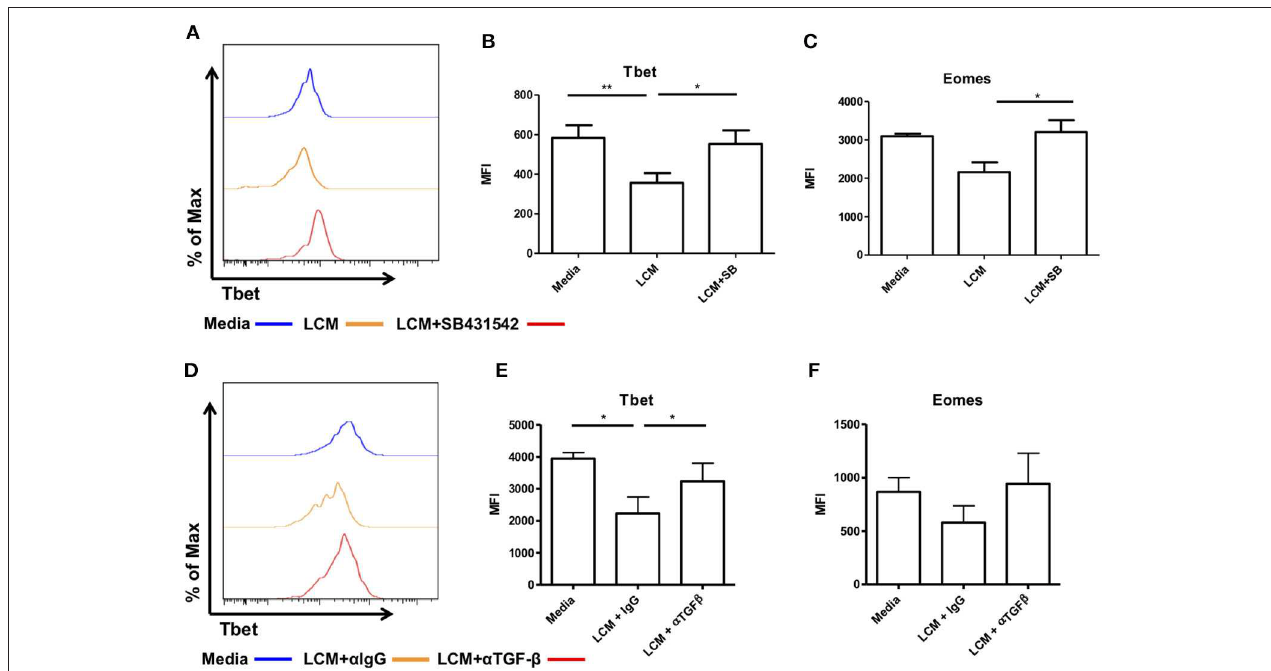
FIGURE 6 | Blocking TGF- β inhibits the ability of liver conditioned media to suppress Tbet and Eomes expression. CD56 bright Eomes hi Tbet lo NK cells FACS isolated from liver perfusate (LP) were cultured for 7 days, supplemented with 10% v/v liver conditioned media (LCM) with and without SMAD inhibitor SB431542 and acquired on a FACS Fortessa. (A) Representative histogram of Tbet expression from cells at day 7 untreated (blue line), 10% LCM (orange line) or LCM & SB431542 (red line). (B) MFI of Tbet in CD56 bright NK cells from LP at day 7 with LCM or LCM & SB431542. (C) MFI of Eomes in CD56 bright NK cells from LP at day 7 with LCM or LCM & SB431542. NK cells isolated from peripheral blood (PB) were cultured for 7 days, supplemented with 10% v/v LCM with 5 µ g/mL anti-TGF- β 1 blocking antibody or IgG isotype control and acquired on a FACS Canto II. (D) Representative histogram of Tbet expression in CD56 bright NK cells from peripheral blood at day 7 with LCM or LCM & TGF- β 1 blocking antibody. (E) MFI of Tbet in CD56 bright NK cells from peripheral blood at day 7 with LCM or LCM & TGF- β 1 blocking antibody. (F) MFI of Eomes in CD56 bright NK cells from peripheral blood at day 7 with LCM or LCM & TGF- β 1 blocking antibody. Data presented as mean ± SEM. Data was analyzed using Friedman test, with Dunn’s multiple comparison test or repeated measures one-way ANOVA ( n = 3–8, * p < 0.05 and ** p <